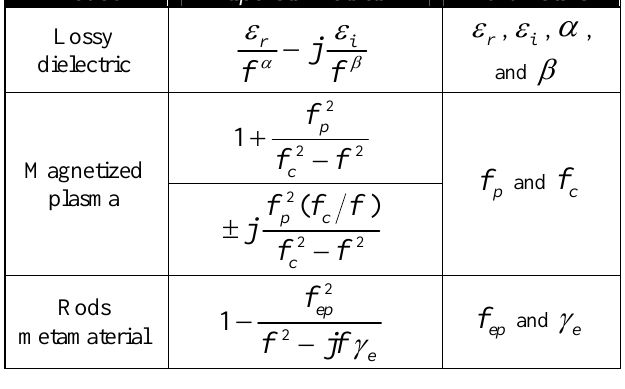
Table 1: Dispersion models of permittivity Model